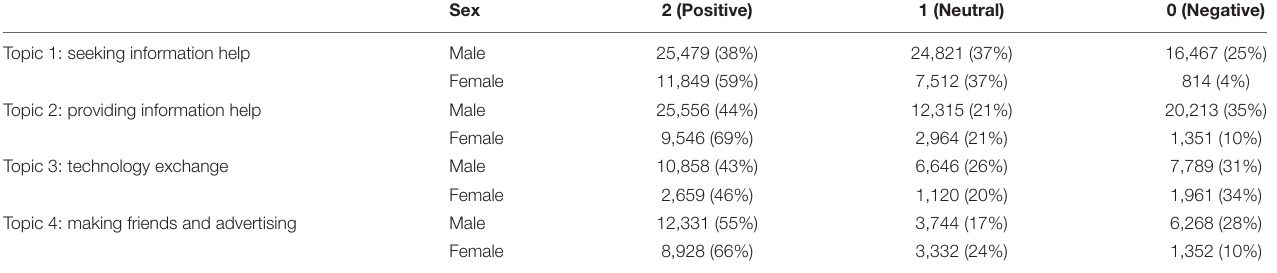
TABLE 4 | Chi-square test results on different